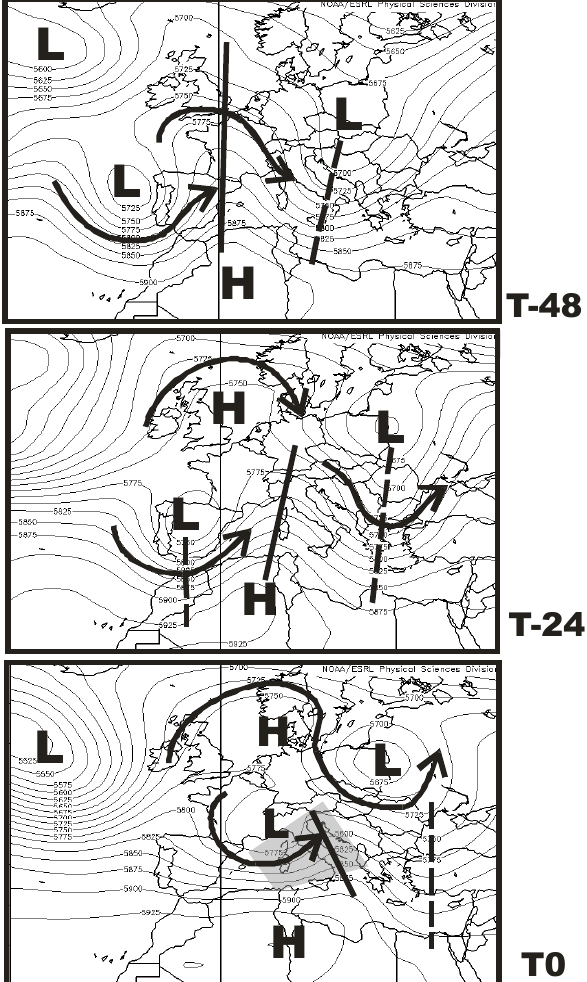
Figure 6. Composite time series at 500hPa for group three consist- ing of two HL events. Heights contours at 100gpm are highlighted (contour interval is 25gpm). Dashed lines indicate troughs while solid lines represent ridges in 500hPa flow. Arrows indicate flow trajectories and shading suggests areas where vertical motion would be expected with flow